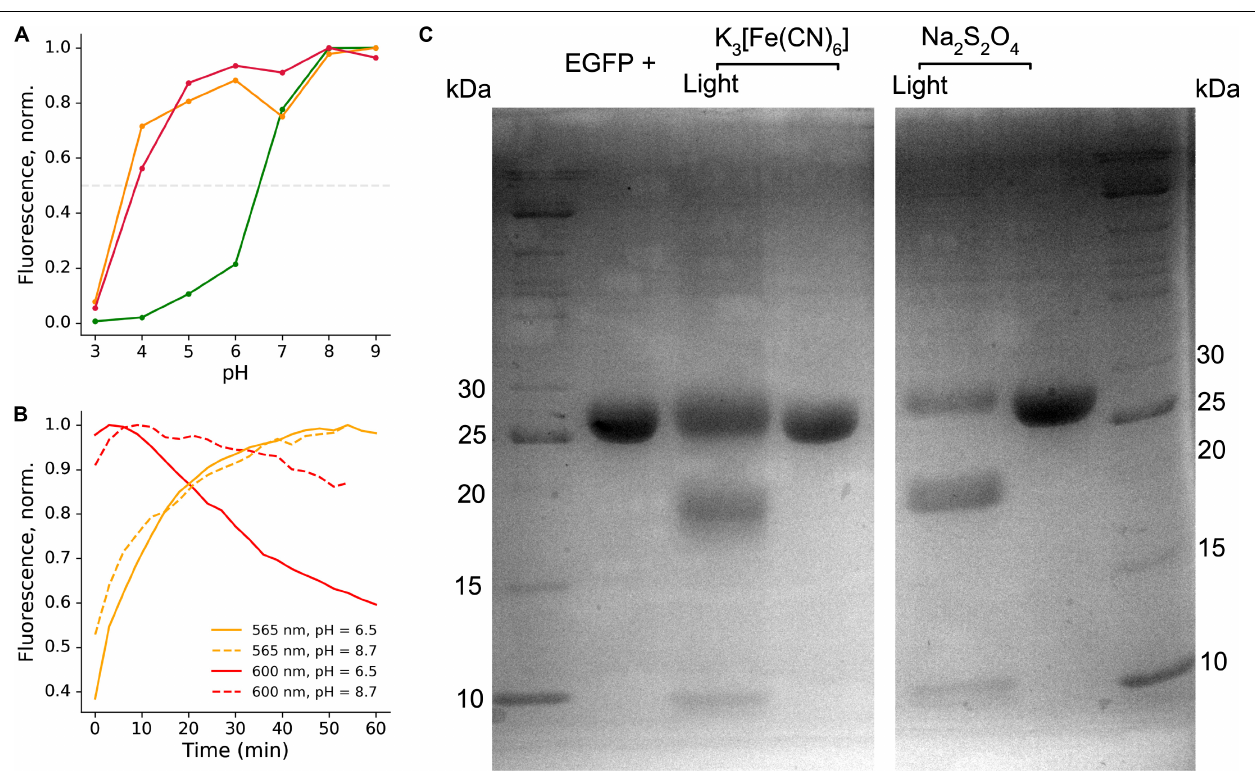
Ser, or Cys (Pletnev et al., 2014). We therefore assessed the ( Figure 5 ) almost indistinguishable from the one observed for EGFP (excitation maximum 500 nm, emission maximum 565 nm). Notably, the red-emitting form (with